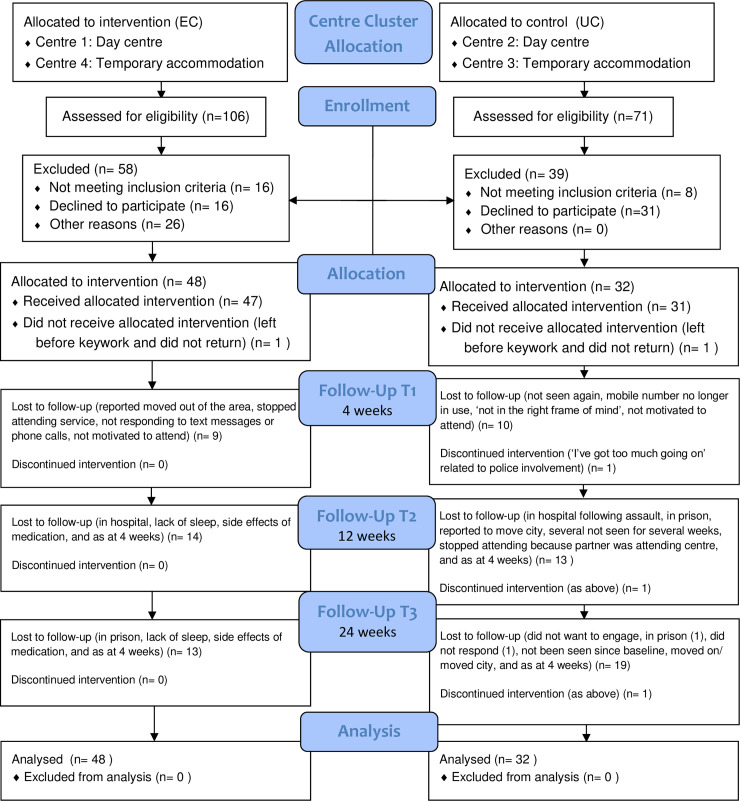
CONSORT flow diagram.